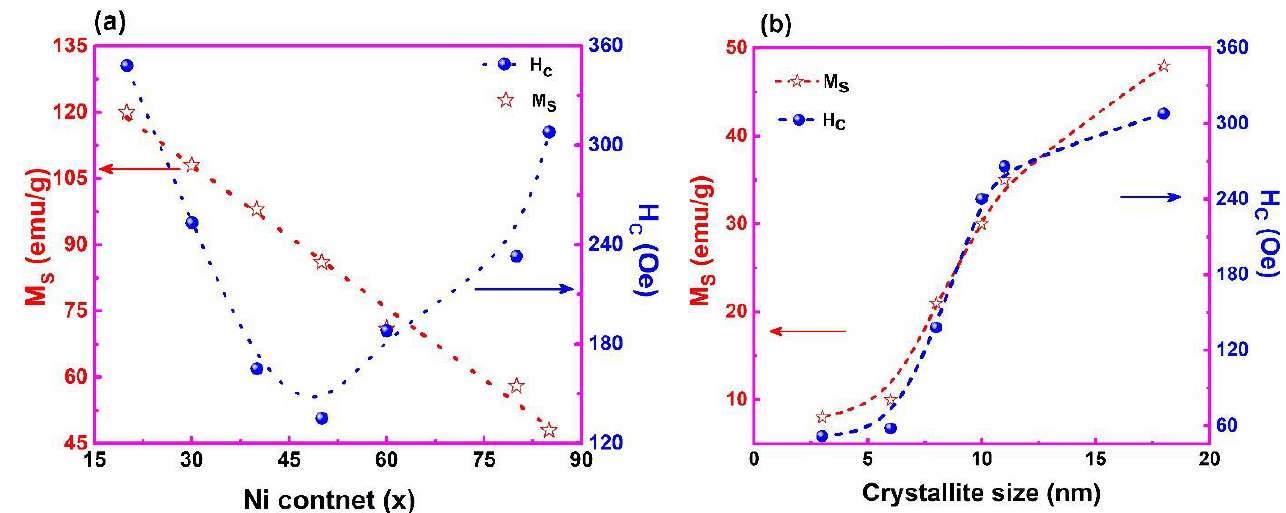
Figure 8. Saturation magnetization M S (measured at 20 kOe) and coercivity obtained from hysteresis loops of ( a ) Co 100−x Ni x NPs milled for 100 min and ( b ) Co 15 Ni 85 NPs milled for 200, 300, 500, 1000, 1200 min as a function of Ni content and average crystallite size, respectively.